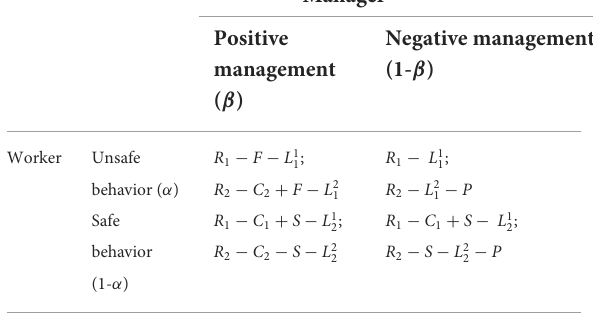
TABLE 2 Payoff matrix of both sides of the game.